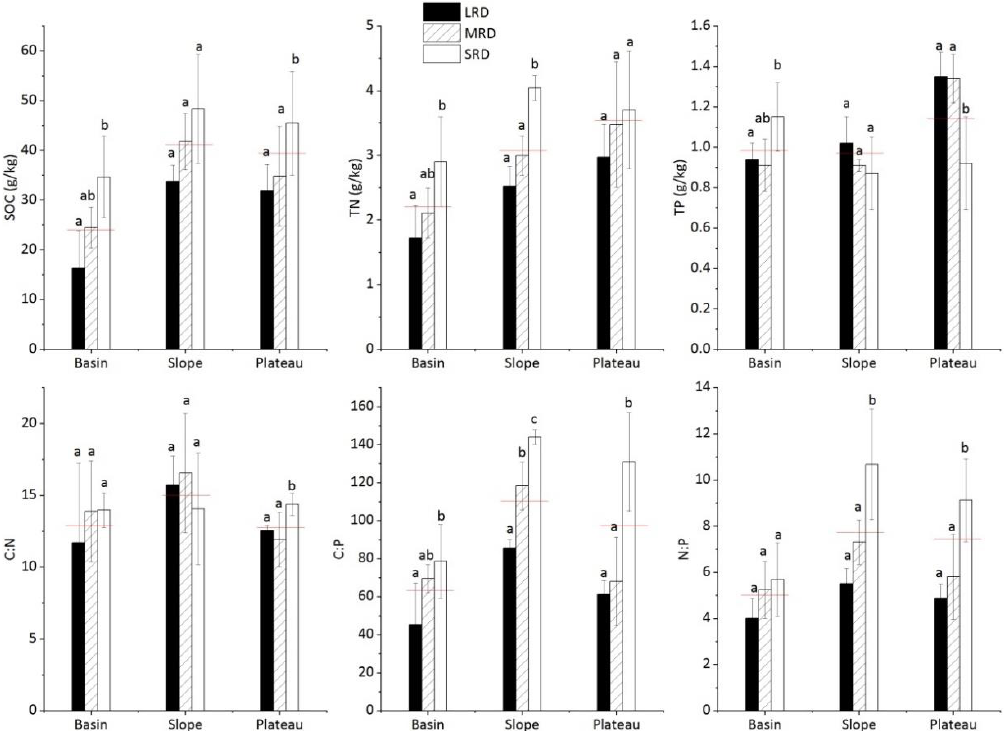
Figure 2. Soil nutrient concentrations and their stoichiometry. The red short line indicates the average value of di ff erent rocky desertification degrees in the same geomorphological location. SOC represents soil organic carbon; TN represents total nitrogen; TP represents total phosphorus; C:N represents the molar ratio of SOC:TN; C:P represents the molar ratio of SOC:TP; N:P represents the molar ratio of TN:TP. LRD represents light rocky desertification; MRD represents moderate rocky desertification and SRD represents severe rocky desertification. Identical letters indicate no significant di ff erences in the average values among soils under di ff erent rocky desertification in the same landform at the 0.05 level.